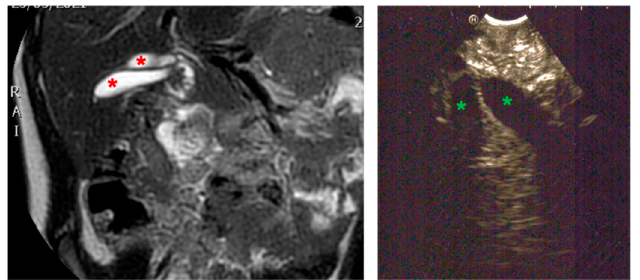
Figure 3. This patient with choledochal cyst (Todani I) and choledocholithiasis was admitted at the age of 4.3 years for cholestatic icterus and acute pancreatitis. ( A , B ): MRCP and 3D reconstructions showed a long common biliopancreatic channel (1.5–2 cm) with dilatation of the biliary tree and a pre-papillary stone. ( C ): Echoendoscopic evaluation (EBUS) confirmed the presence of a choledochal cyst (diameter 12.8 mm, green asterisk) and a 6 × 7 mm stone in the common biliopancreatic channel (17.9 mm). The main pancreatic duct was dilated (6.3 mm), and the accessory pancreatic duct appeared ecstatic (2.5 mm). ( D1 , D2 ): ERCP (endoscopic retrograde cholangiopancreatography) using the 11.6 mm duodenoscope with a lateral view; the choledocus appeared dilated in its middle portion as for type I Todani choledochal cyst with dilatation of the cranial biliary tree. The stone was removed after biliary sphincterotomy.